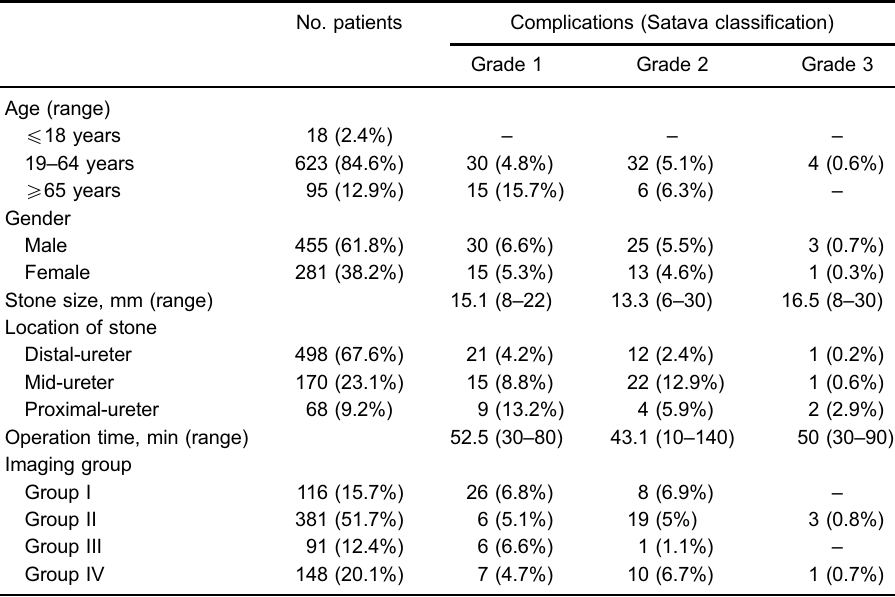
Table 3. Clinical data in relation to